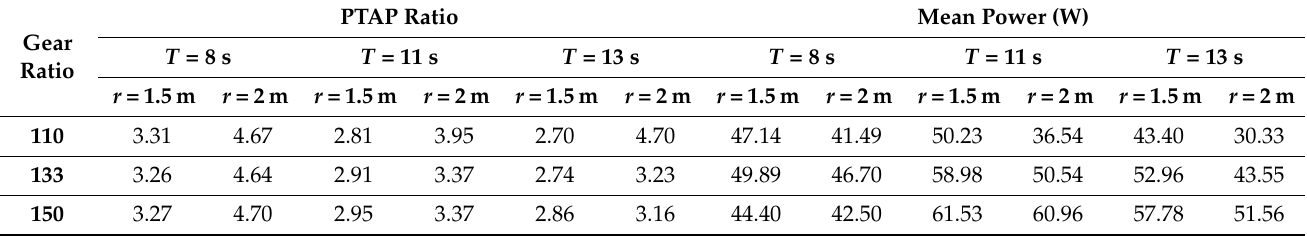
Table 4. PTAP ratio and mean power for a regular wave with a fixed-wave height ( H = 2.5 m).